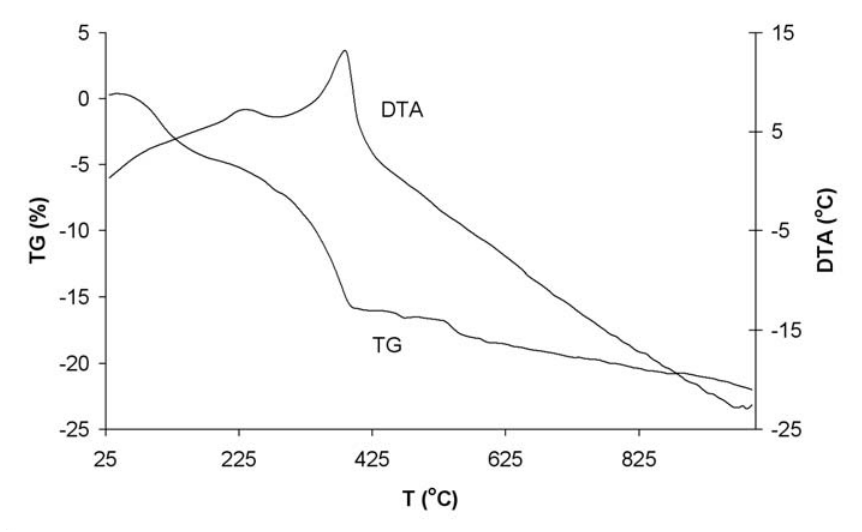
Fig. 6 Thermal decomposition (TG and DTA) curves of the silica-immobilised ( via co- valent bonds, SG–c–Cu-tren) Cu-tren complex. (DTBQ) in the presence of dioxygen (Scheme 2). The amount of the evolved DTBQ